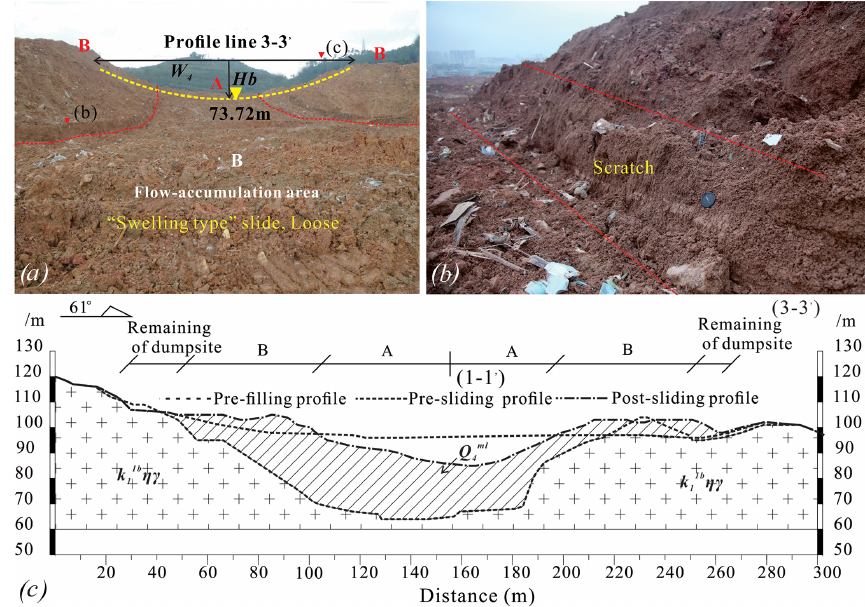
Figure 13. (a) The half-elliptic-like opening of the failed retaining slope; (b) details on the scratch caused by mass movement; (c) geological cross section (profile line 3-3’) of the failed retaining slope located at the original quarry pit between the two rock